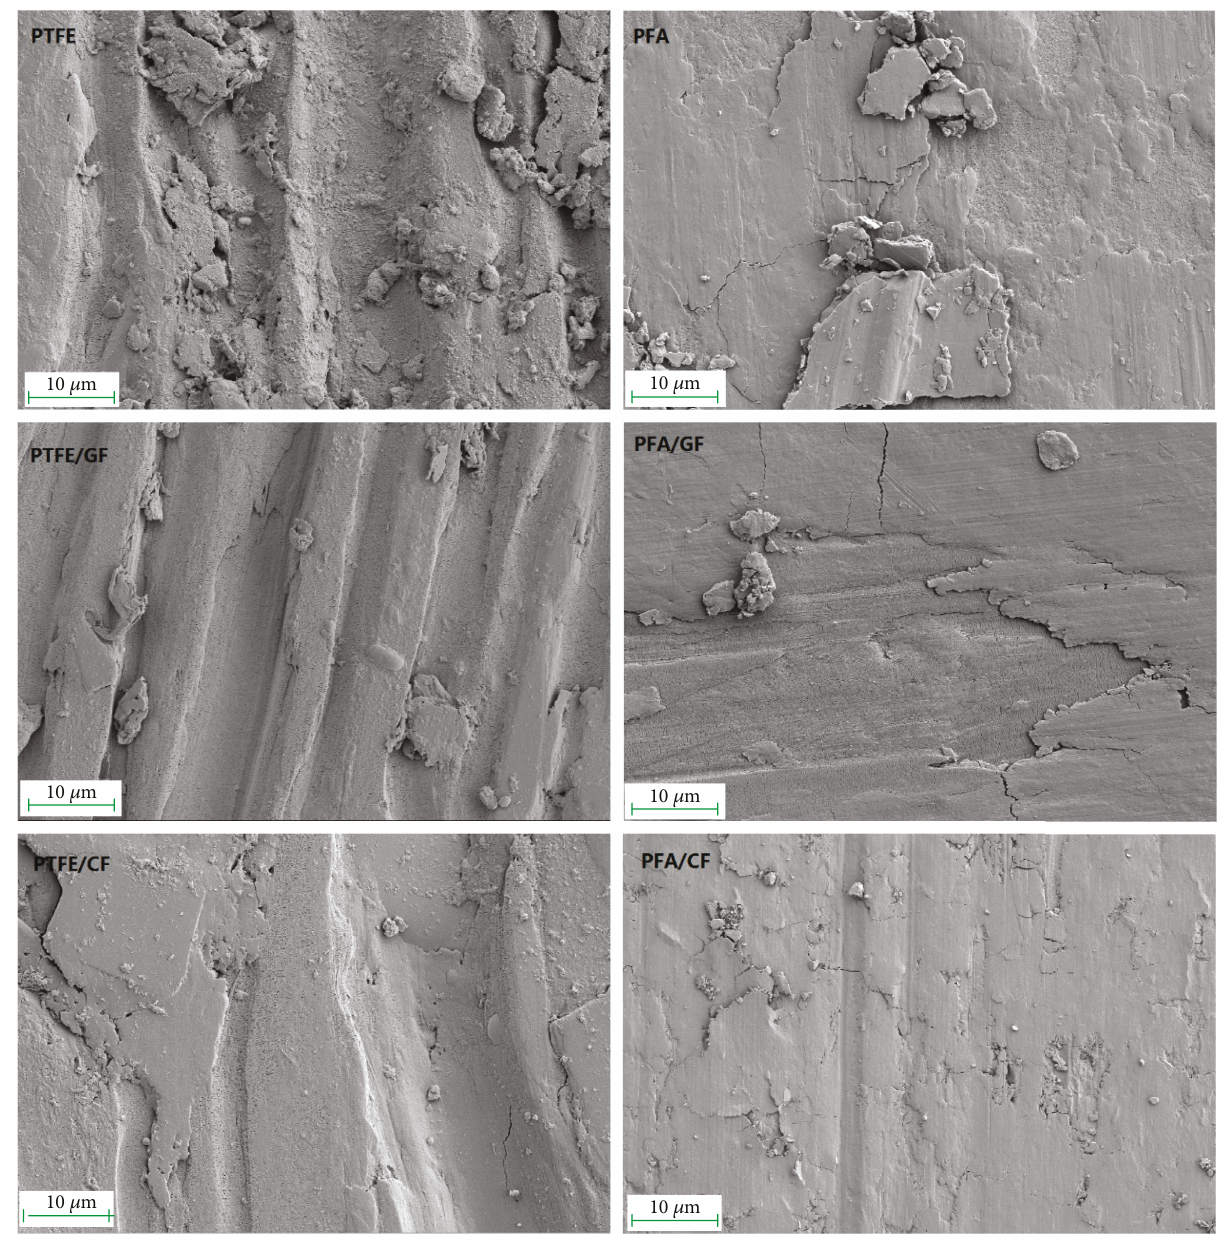
Figure 5: SEM worn surfaces of the PTFE and PFA